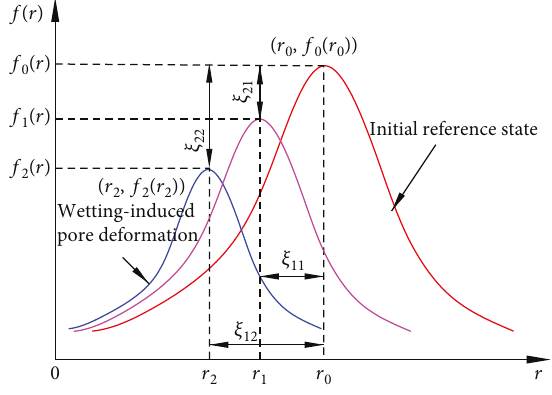
Figure 4: In fl uence of pore deformation on